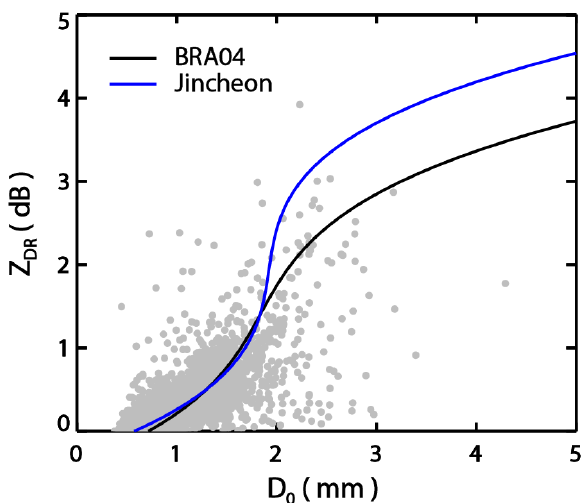
Figure 11. Same as Figure 10, but with the polynomial fitted from BRA04 (black) and to the Jincheon: BR03-VPR data (blue).